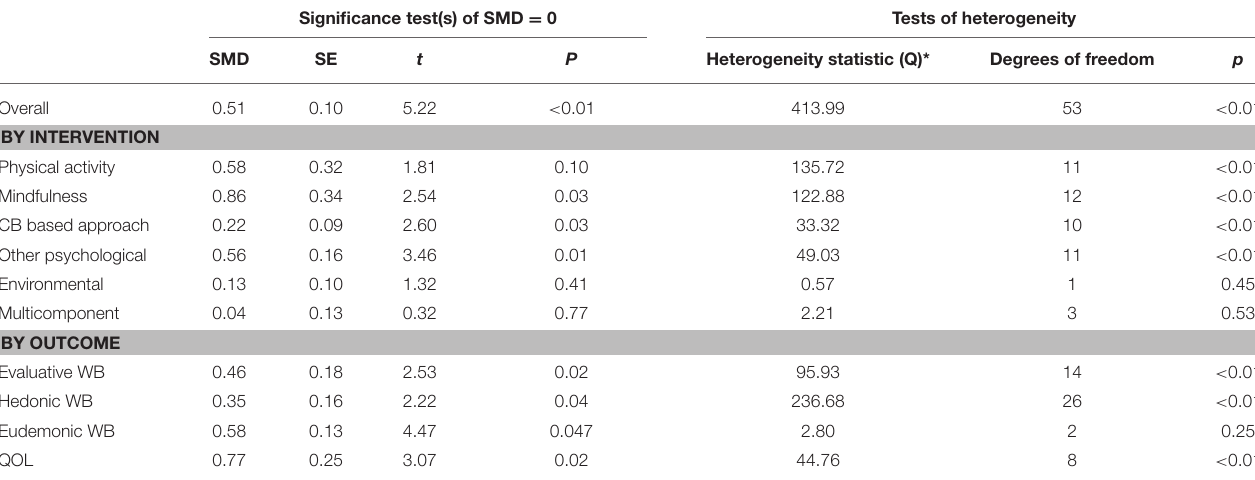
TABLE 3 | The pooled effects of intervention on subjective well-being (SWB) and test of heterogeneity: three-level random-effects meta-analysis. Significance test(s) of SMD =